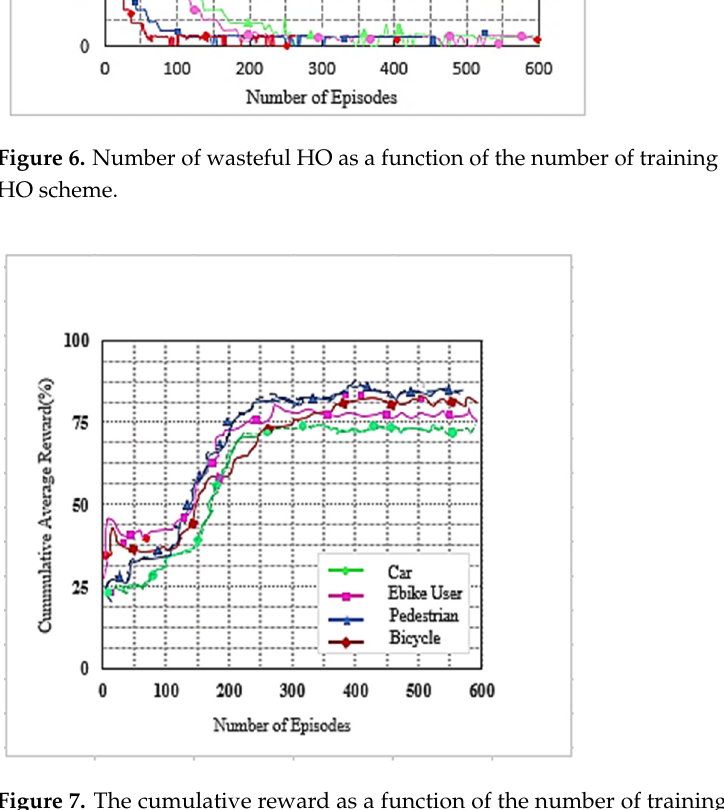
Figure 7. The cumulative reward as a function of the number of training episodes for DDPG only HO scheme according to user type.